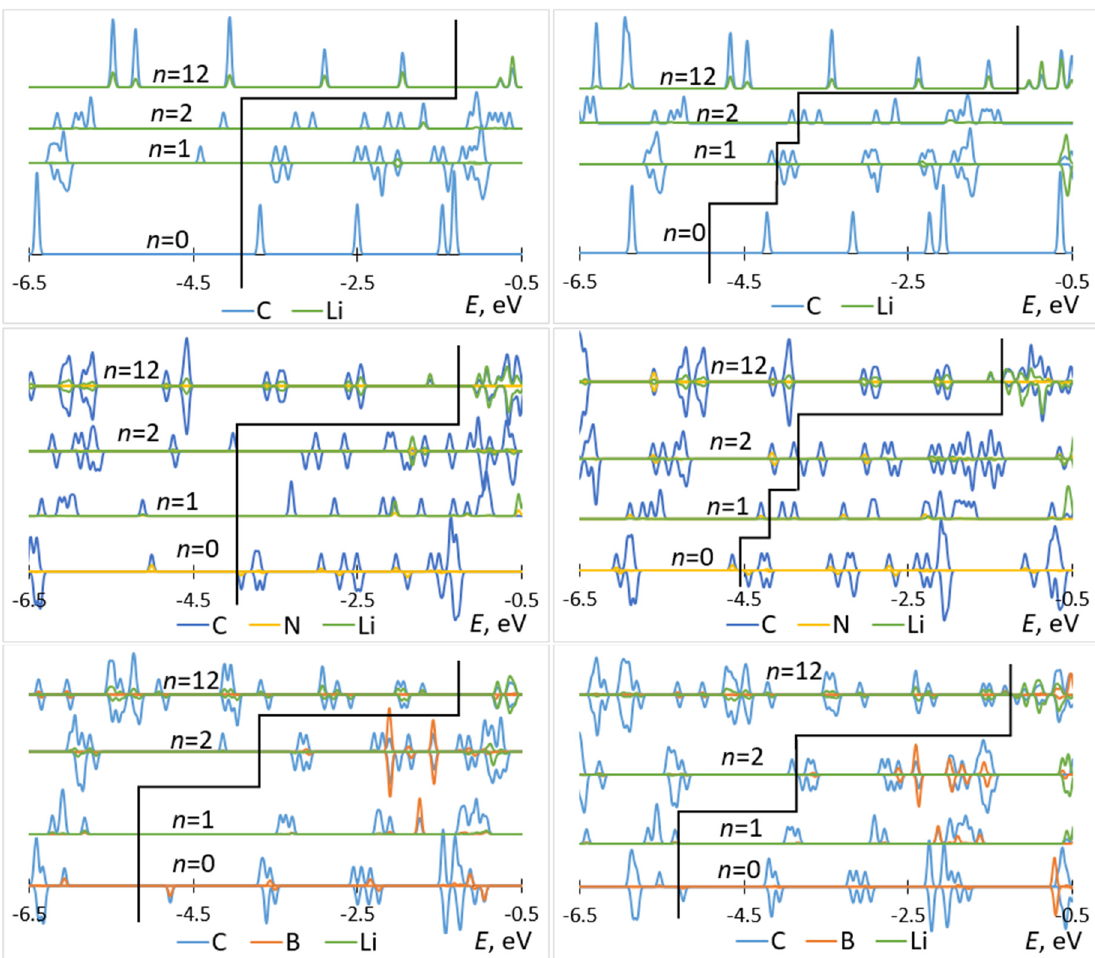
Figure 5. Partial densities of states of Li n –C 60 (top panels), Li n –C 59 N (middle panels), and Li n –C 59 B (bottom panels) computed with B3LYP (left panels) and PBE (right panels) for selected values of n . The black elbow line is used to mark off occupied (left) and unoccupied (right) states.